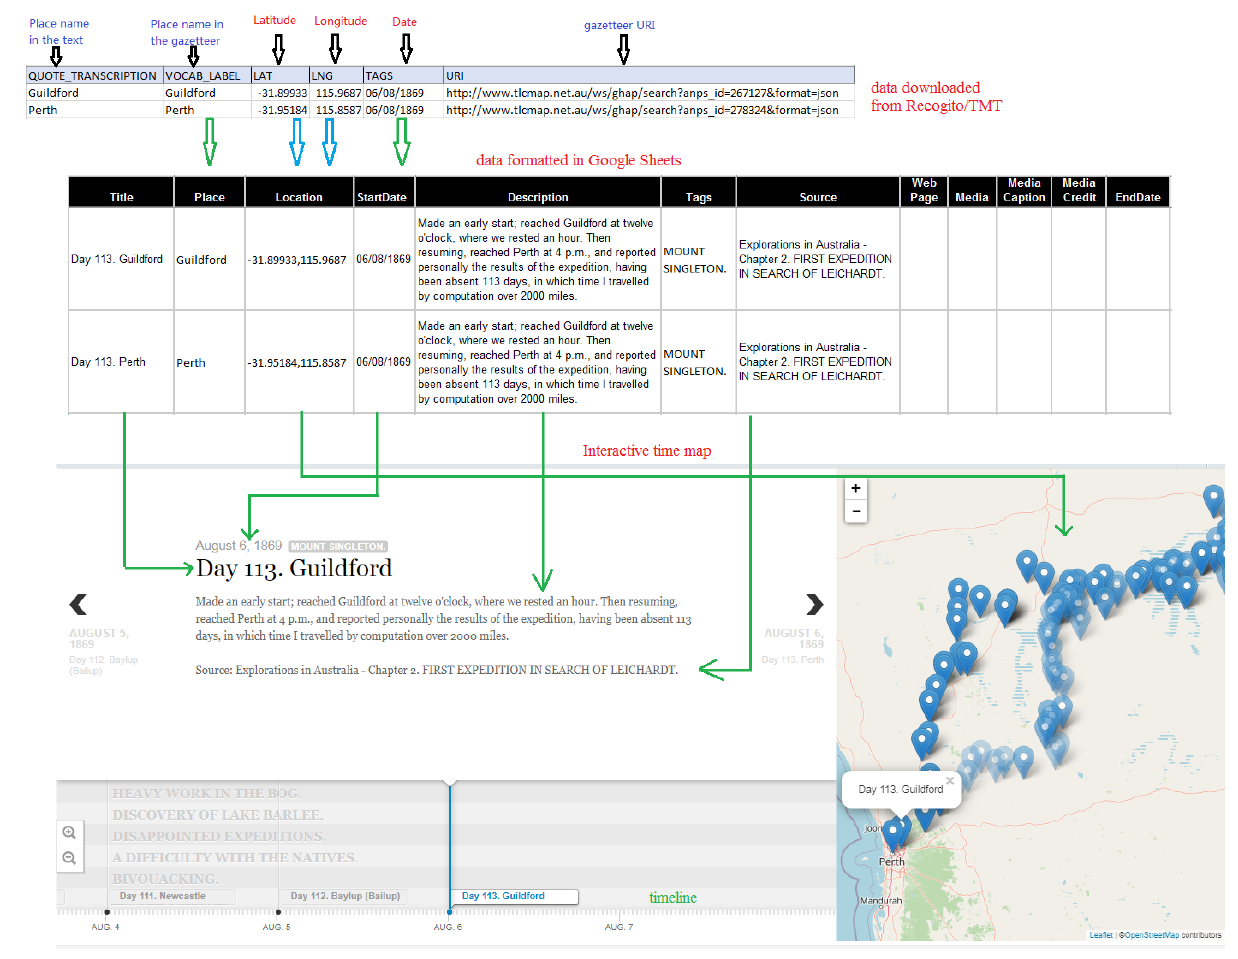
Figure 4. Workflow showing data downloaded from Recogito/TMT to an interactive time map built in TimeMapper.